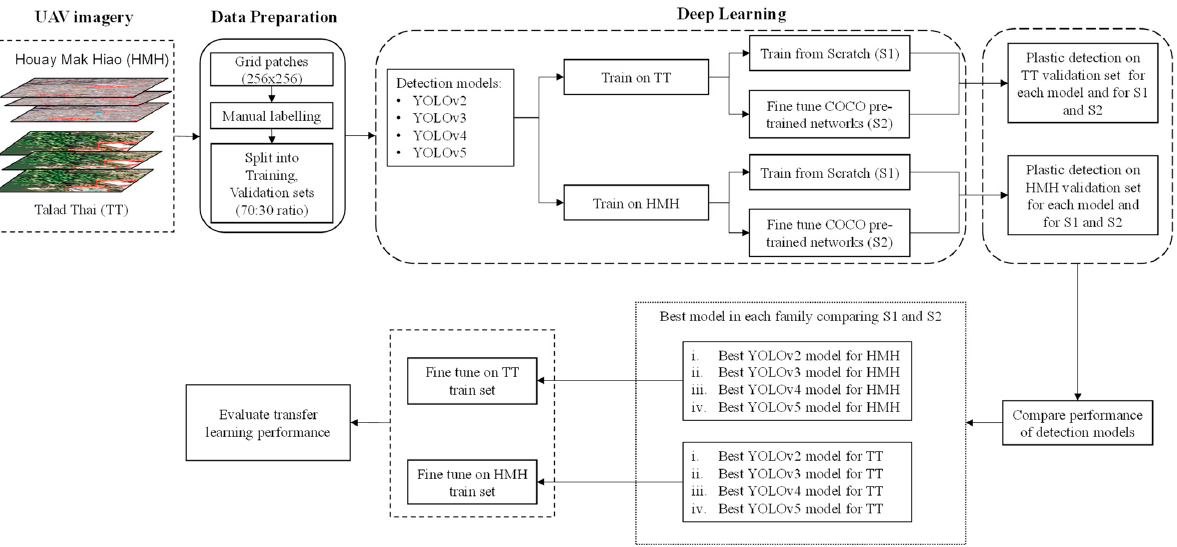
Figure 4. Methodological framework for assessment of performance of deep learning architectures for plastic detection.